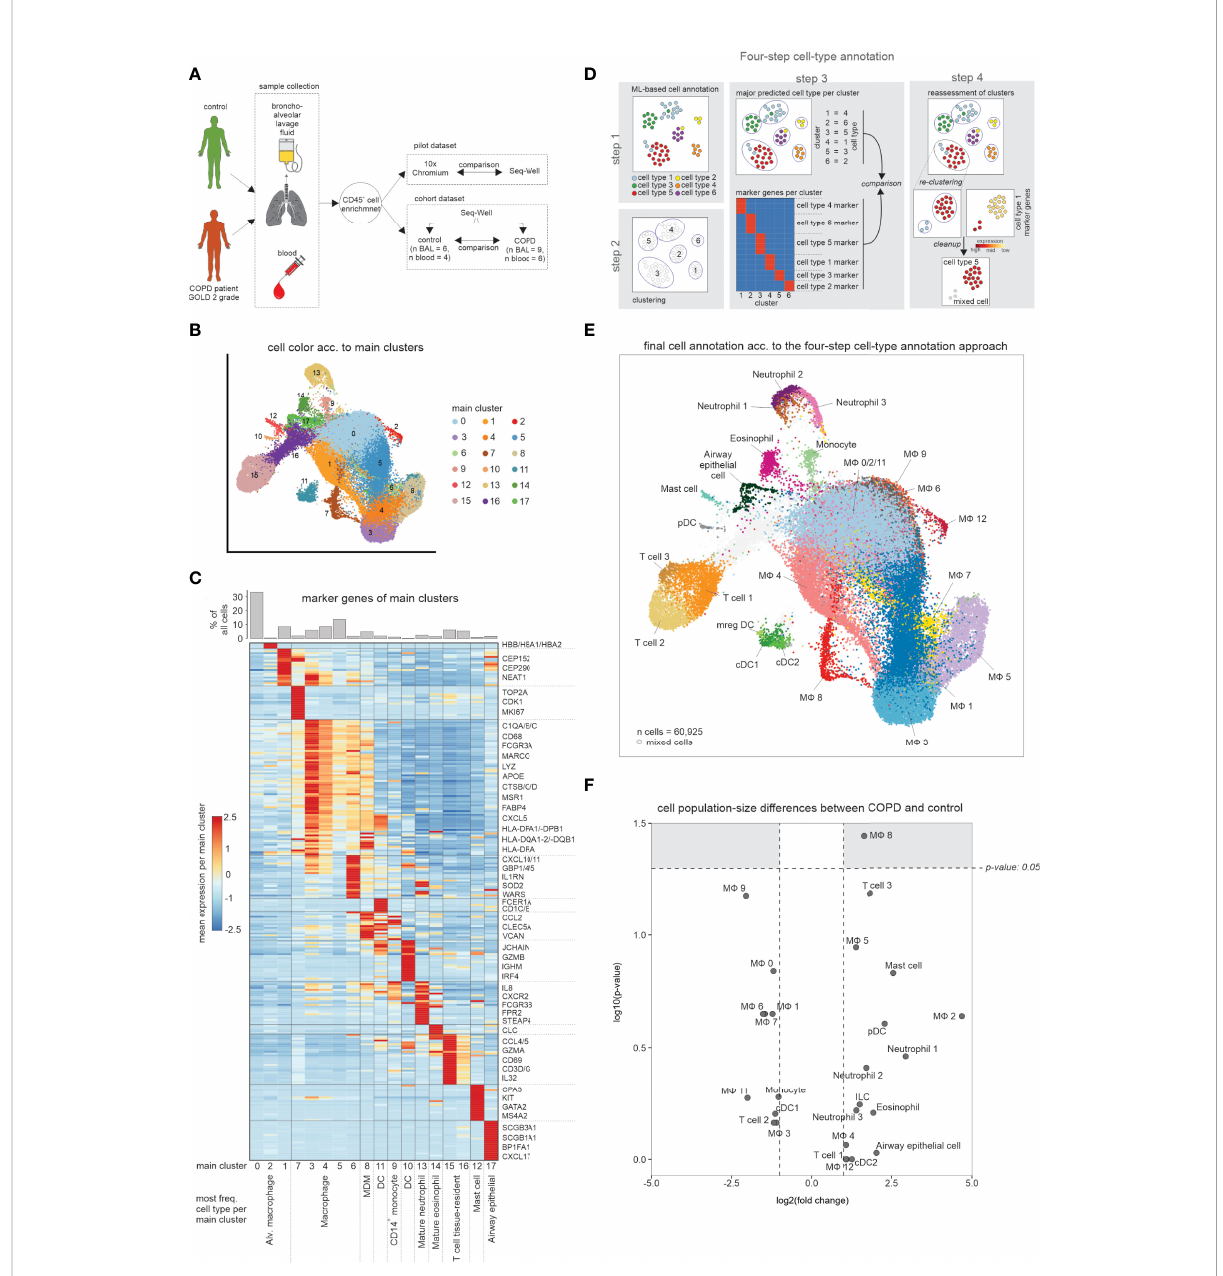
FIGURE 1 scRNA-seq data of BALF samples obtained from COPD patients and healthy controls. (A) Schematic work fl ow of the present study. Bronchoalveolar lavage fl uid (BALF) and peripheral blood was obtained from control donors and COPD patients (GOLD stage 2). After enrichment for immune cells (CD45+ cells), single-cell RNA-seq was performed. (B) UMAP representation of integrated BALF data obtained from all COPD patients and control donors. Coloring and numbering according to identi fi ed main clusters. (C) Heatmap of the calculated marker genes per main cluster with a bar chart representation of the relative cell type proportions at the top. The marker gene expression per cluster is represented as a z-transformed value (across all clusters). Rows of the heatmap are clustered hierarchically. At the bottom of the plot, the main cell type is displayed, which is contained in the respective main cluster. (D) Schematic work fl ow of the four-step annotation approach, including machine learning-based cell type annotation, clustering, assignment and subsequent con fi rmation of a cluster to a cell type according to the machine learning-based cell type annotation, and identi fi cation of ‘ contaminating ’ cells (referred to as ‘ mixed cells ’ ). (E) Final cell type annotation of integrated BALF data according to the four-step annotation approach. (F) Volcano plot visualization of log2 fold changes and negative log10 p-values (Wilcoxon rank sum test) of changes in cell type occurrence in BALF of samples obtained from COPD patients and controls. BALF, bronchoalveolar lavage fl uid; alv., alveolar; MDM, monocyte-derived macrophage; DC, dendritic cell; n, number; M Ф ,